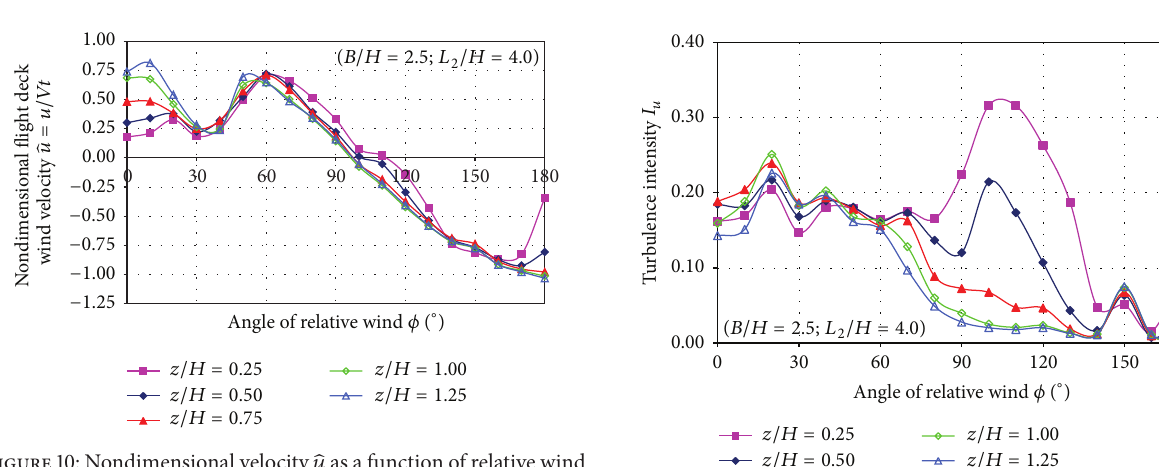
Figure 10: Nondimensional velocity ̂𝑢 as a function of relative wind angle.